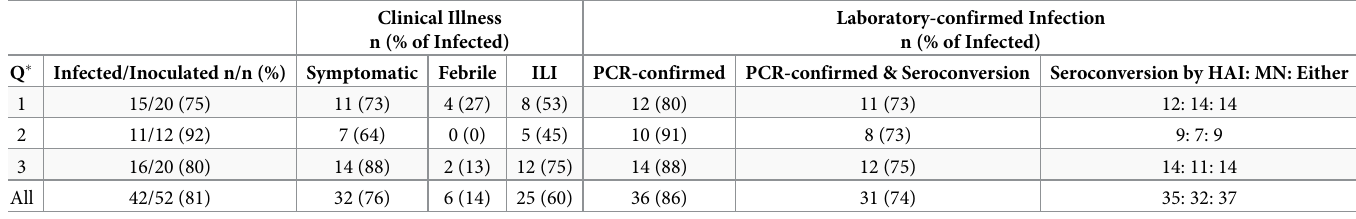
Table 1. Infected donor status.